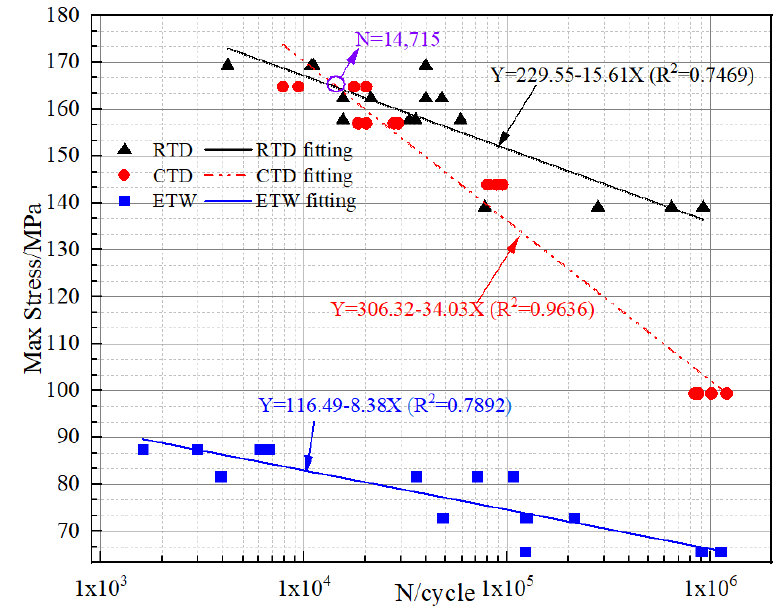
Figure 5. S-N curve of angel-ply laminates in three environments.